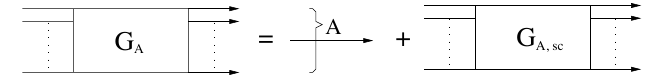
Figure 4. Splitting of the A -particle cluster propagator into a bound and scattering contribution. Note that the internal quantum number has been